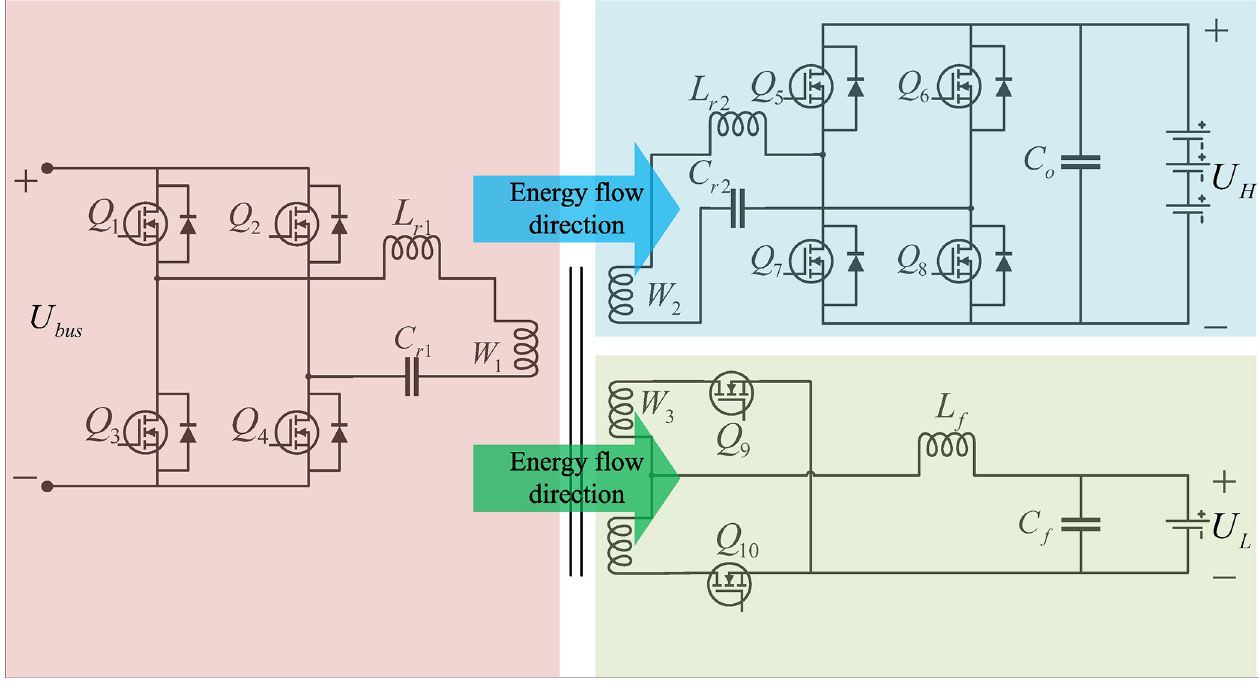
Fig 3. Parked charging